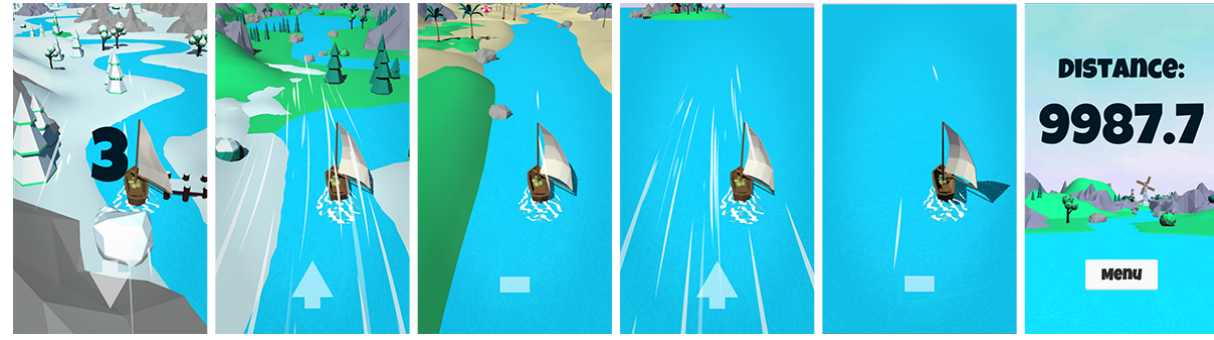
Figure 4. All phases of a breathing training session from Breeze are depicted from left to right: countdown, traveling from a snowy to grassy landscape, traveling from a grassy landscape to sandy beaches, reaching the open sea by passing a small island, traveling further into the sea, and finally, the score screen showing the distance traveled.